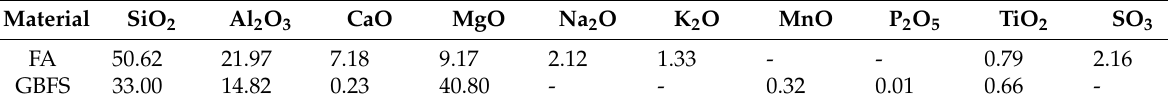
Table 1. Chemical composition of FA and GBFS (wt%).